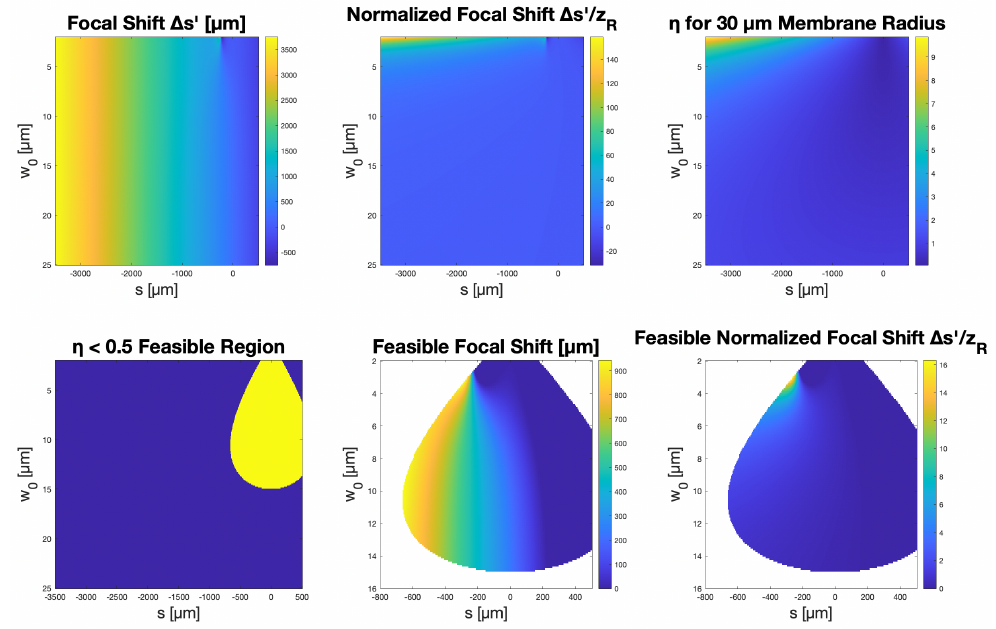
Figure 5. Simulation results for 30 µ m membranes and 150 nm deflection using a 532 nm